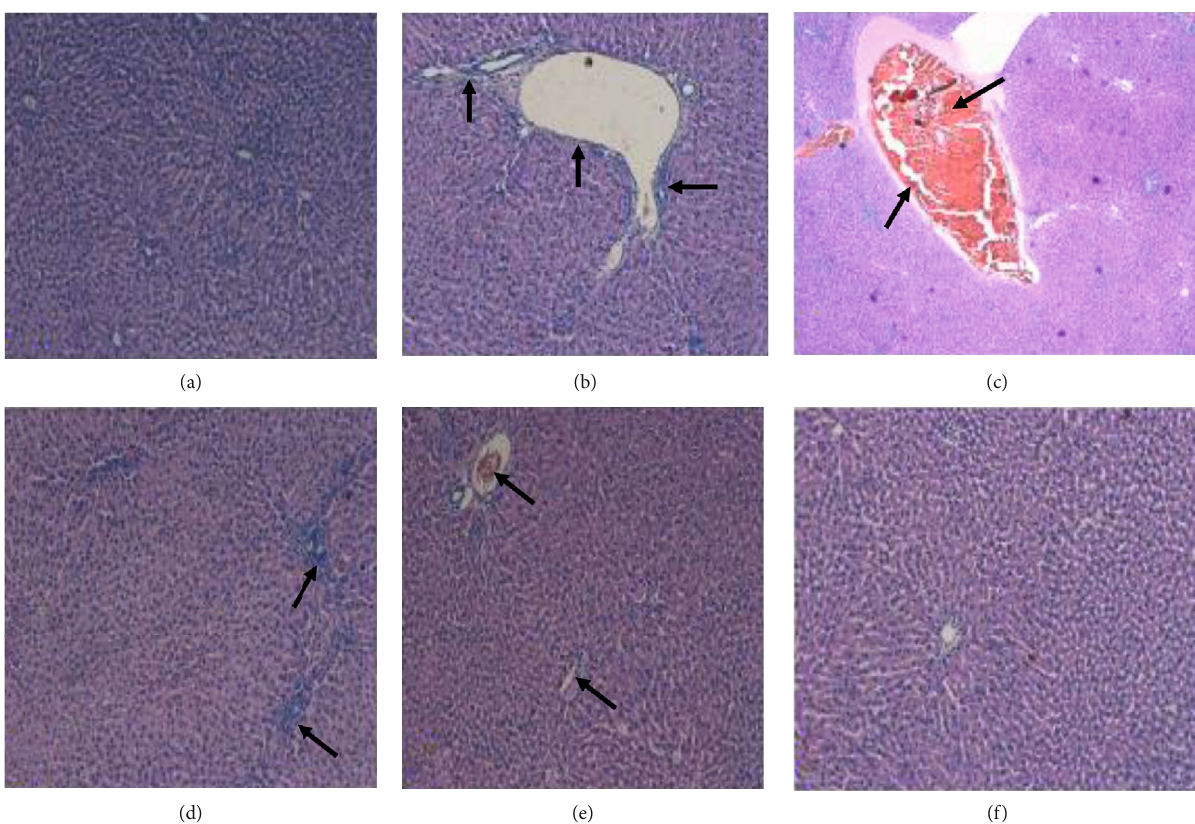
Figure 11: Histopathological analysis. Liver tissues showing (a) the normal architecture of hepatocytes in liver sections of control group rats. DEN-only treated tissues showing various types of alterations (arrows shown) such as blood vessel dilation, congestion, and increased in fl ammatory cells (b – d). 6-Gingerol plus DEN-treated tissue showed that liver tissue alteration was signi fi cantly less as compared to the DEN-treated group (arrows shown) (e). 6-Gingerol-only treated group shows normal hepatocyte architecture